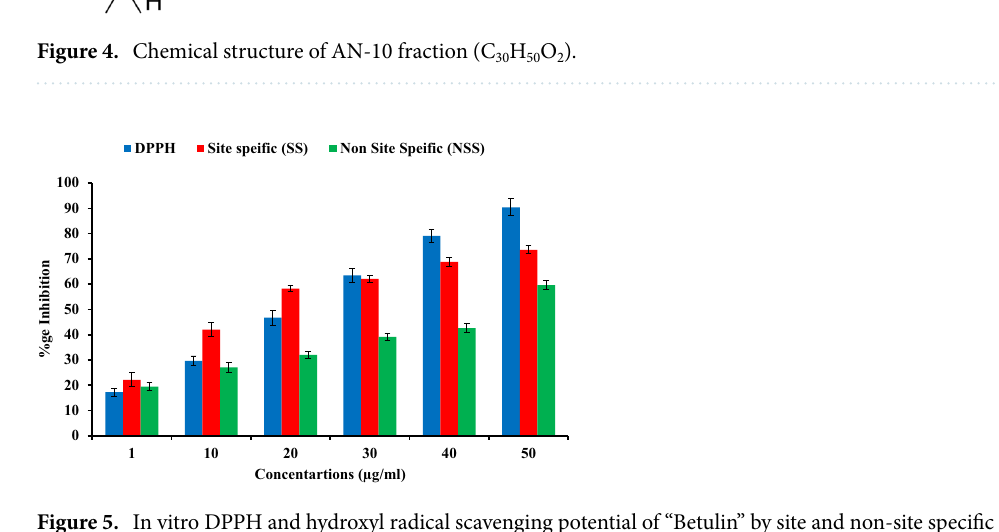
Figure 5. In vitro DPPH and hydroxyl radical scavenging potential of “Betulin” by site and non-site specific deoxyribose degradation